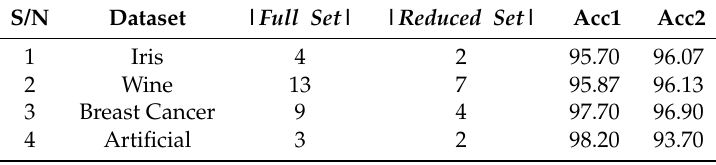
Table 7. The average accuracy for the full and the reduced datasets.